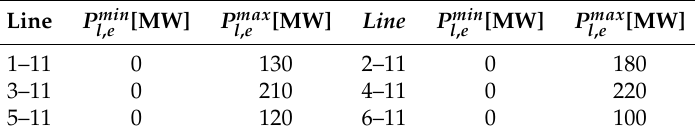
Table A5. The capacity limit parameters of power network lines.